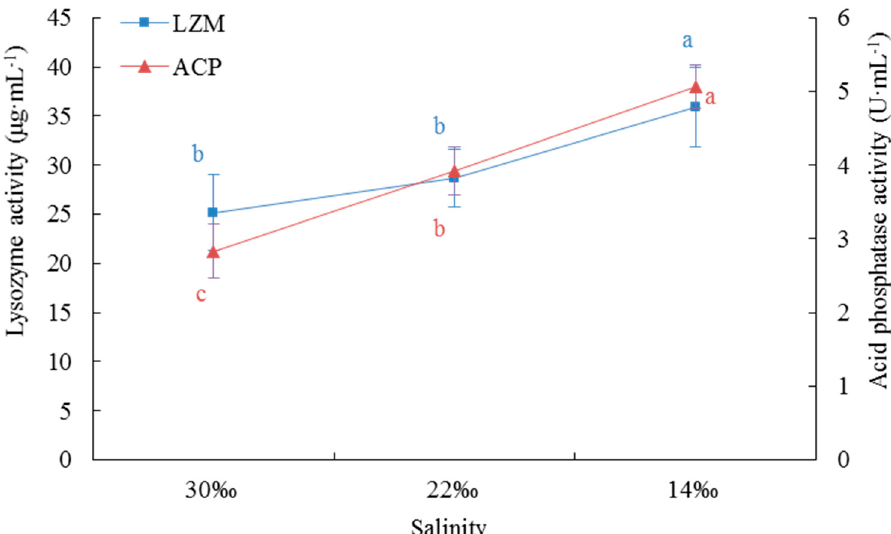
Figure 1. Effects of a sudden drop in salinity on the activities of lysozyme (LZM) and acid phosphatase (ACP) in Anadara kagoshimensis . Values are expressed as mean ± SE ( n = 9). Statistical analysis was performed by one-way ANOVA followed by Tukey’s test using SPSS version 18.0. Means with different lower case letters are significantly different at p < 0.05 level.